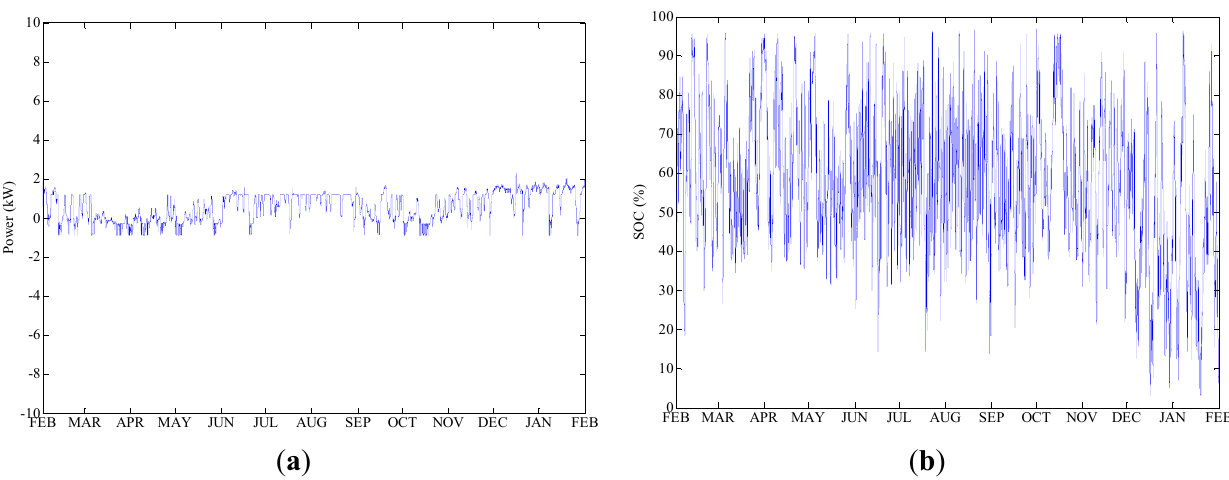
Figure 18. ( a ) Power exchanged with the grid and ( b ) useful SOC during a